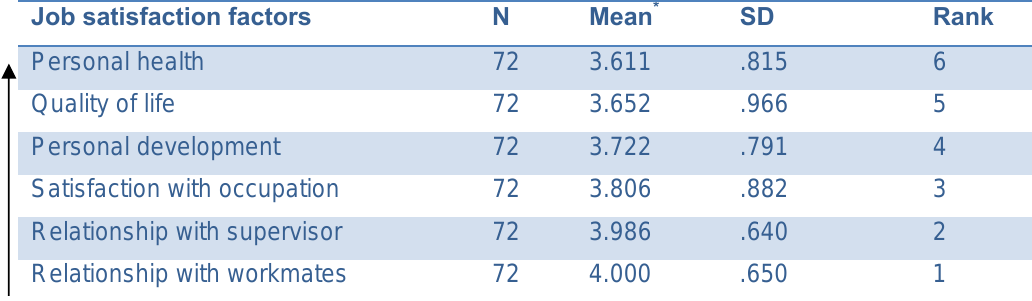
Table 3: Job satisfaction scores